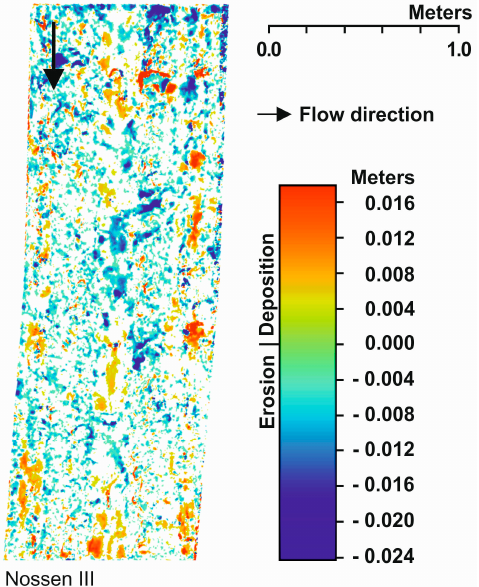
Figure 8. The corrected DoD of the Nossen III-plot in the resolution of 1 × 1 mm.